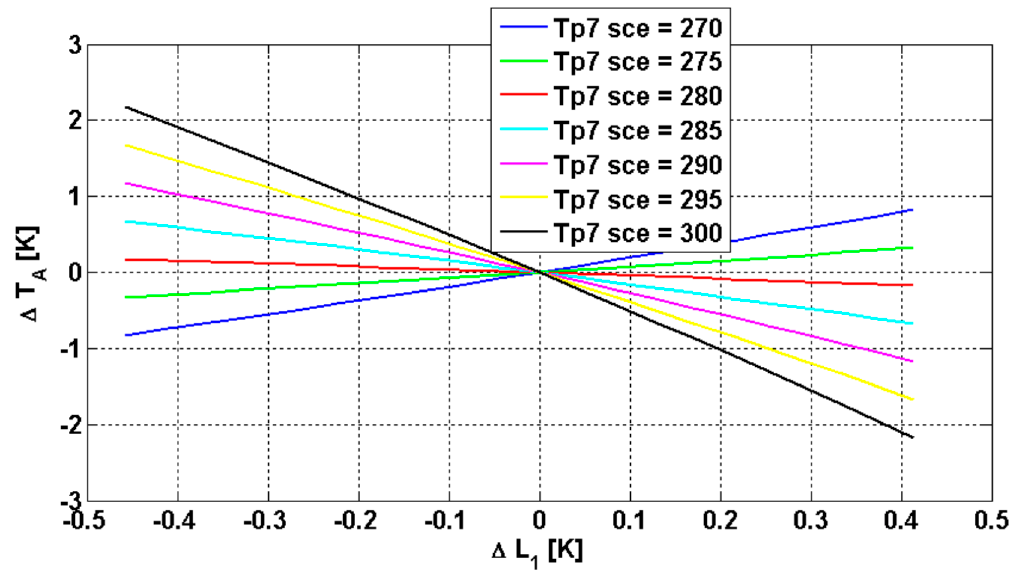
Figure 4. Expected error in the antenna temperature as a function of the error in the antenna losses (L1), for simulated scenarios with different temperatures, when the calibration of the NIR was obtained at a temperature of Tp7 = 295K.